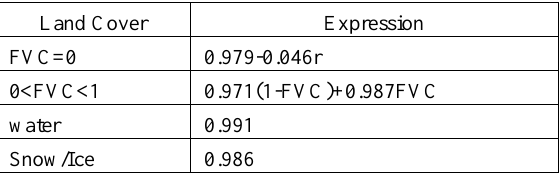
Table 7. Expressions with reference to Conditions for TIRS